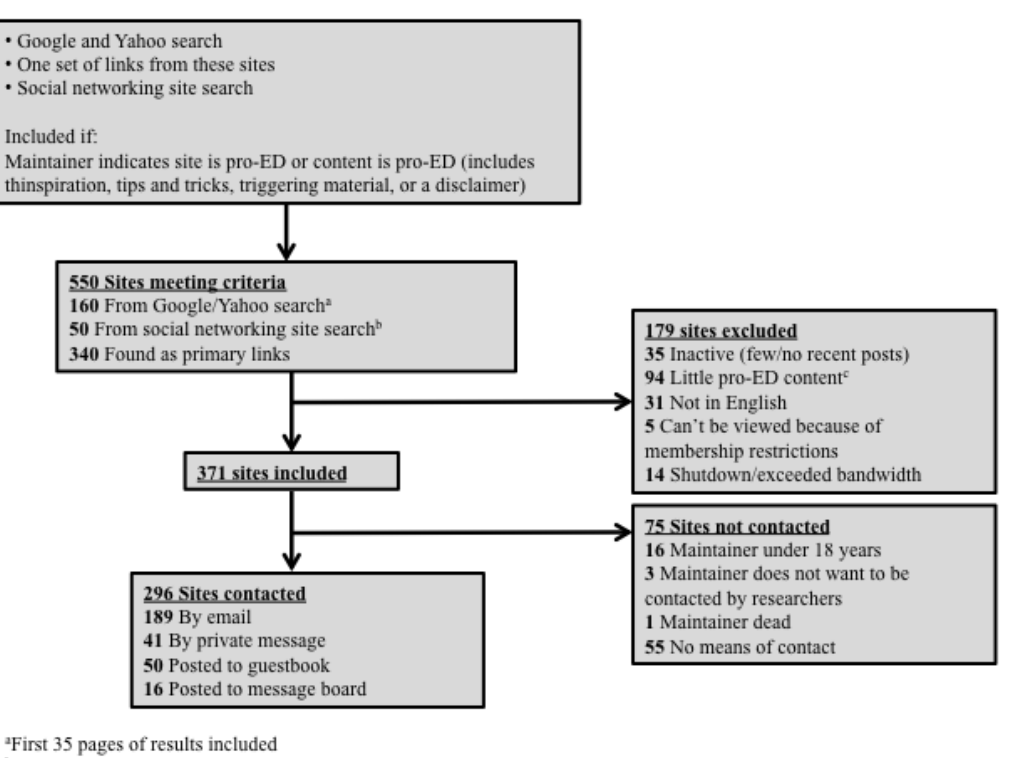
Figure 2. Website search results. a First 35 pages of results included. b Groups with 500 or more members included. c Included in this category are pro-ED (eating disorder) sites under construction with little ED content, pro-ED sites no longer containing content because maintainer went into recovery, sites with primarily non-ED-related content, and sites containing only links to other